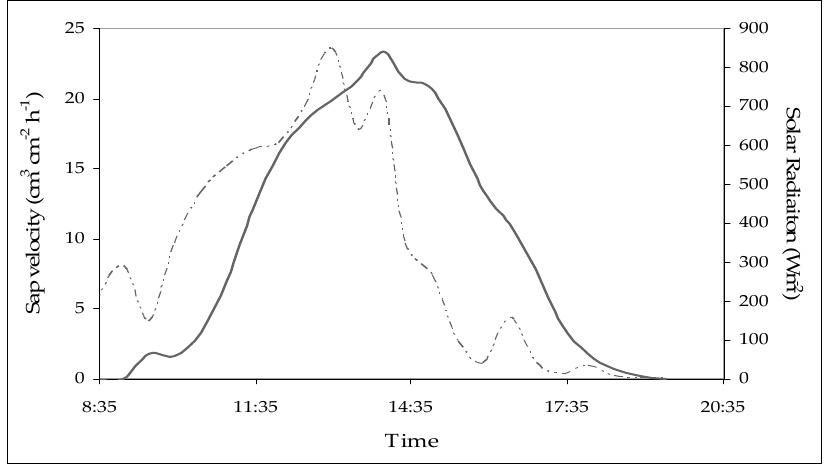
Figure 5. An example of a Trembling aspen tree diurnal sap flow. Tree’s diameter at breast height was 31 cm. Day of the year: 228, in 2004. Dashed line is R s and the solid line is J i .